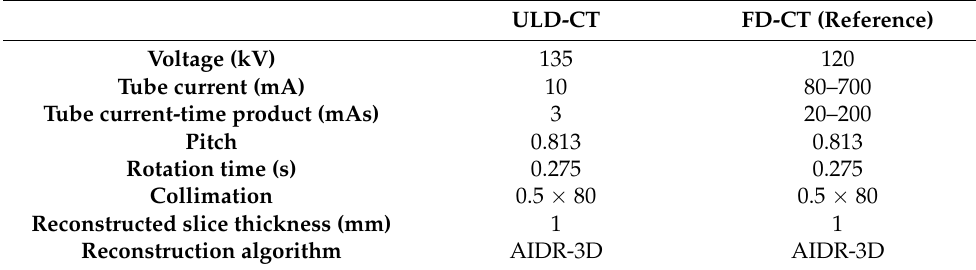
Table 1. Acquisition parameters of study protocols.